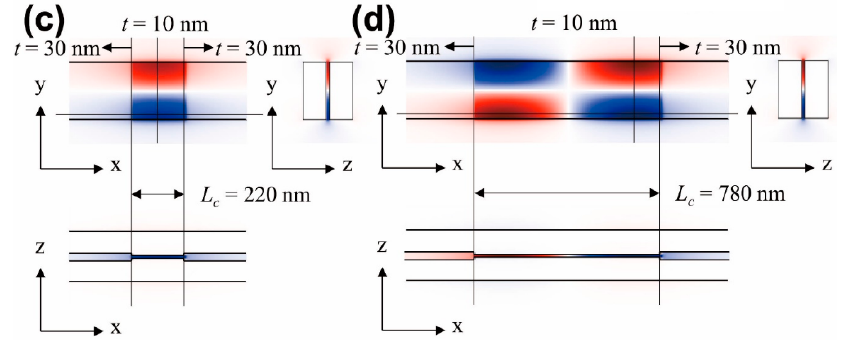
Figure 4. ( a ) Schematic of a cavity consisting of a cavity waveguide ( t = 10 nm) and two mirror waveguides ( t = 30 nm). The gap size between the two silver strips is modulated. In the gap, a low ‐ index dielectric layer ( n = 1.5) is assumed. Here, w = 240 nm, L m = 1000 nm, and the heights of the cavity and mirror waveguide silver strips are 100 nm and 80 nm, respectively. The cavity waveguide length is L c ; ( b ) Dispersion curves of the first ‐ order waveguide modes for t = 10 nm (blue) and t = 30 nm (red). The cutoff frequencies (wavelengths) are 2 π f = 1059 THz (1779 nm) and 1945 THz (1414 nm). The light line is indicated by the blue line; ( c , d ) Top and side views of the electric field profiles of the fundamental ( L c = 220 nm) and second ‐ order ( L c = 780 nm) cavity modes.